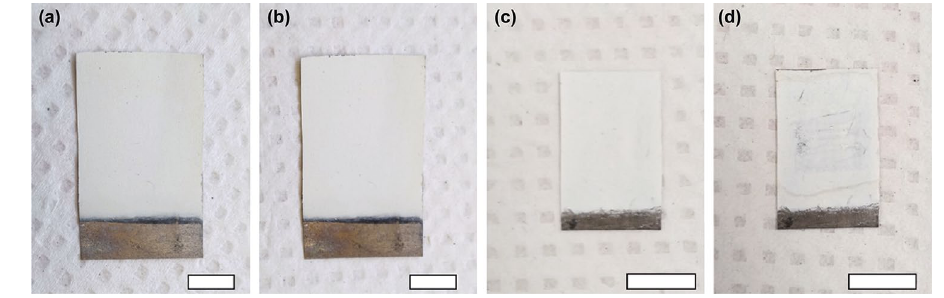
Fig. 2 Digital images of the C-T generator: a before test, b after test. Similar images for the TiO 2 NWs generator: c before test, d after test. The scale bar is 1 cm